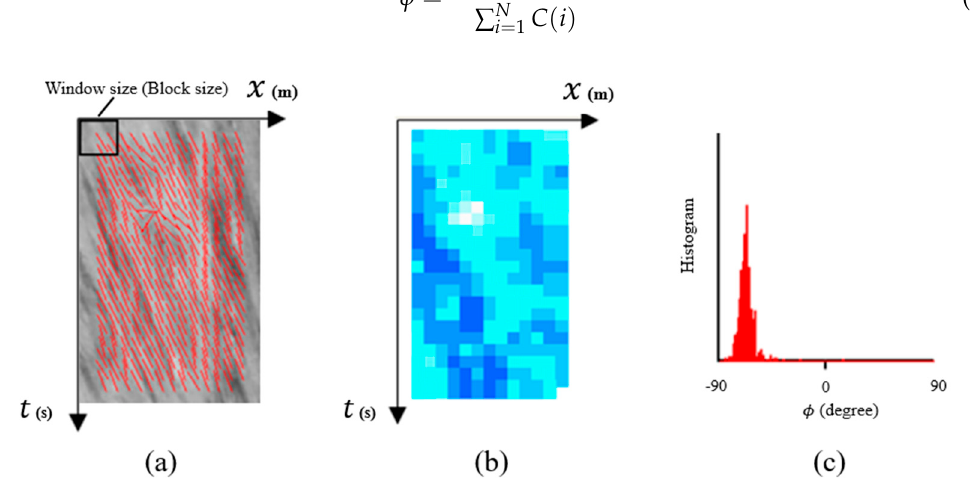
Figure 3. Process of the gradient tensor method: ( a ) calculated pattern angle with each block; ( b ) calculated coherency with each block; ( c ) a histogram of the pattern